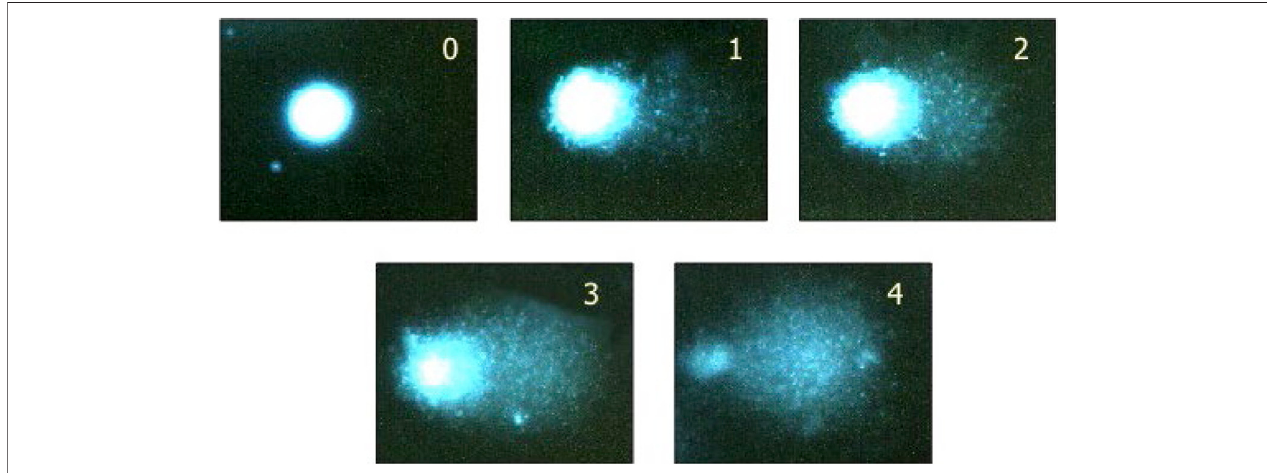
FIGURE 1 | Visual scoring - an acceptable option if image analysis is not available. By eye, it is possible to classify comets into fi ve categories, corresponding to thesetypical images. Examining100comets inthisway,and givingscorescorrespondingtotheclasses(0,1,2,3,4), thetotalscorewillbebetween0and 400,roughly equivalent to 0 – 100% tail DNA. See Collins, 2004 (Collins, 2004) for more details, including a direct comparison of visual scoring with computer image analysis (Note: a class 4 comet would commonly be referred to as a ‘ hedgehog comet ’ .) While visual scoring is possible, automated scoring is recommended, to avoid bias in data interpretation. Reprinted from Collins, 2004, by permission of Springer